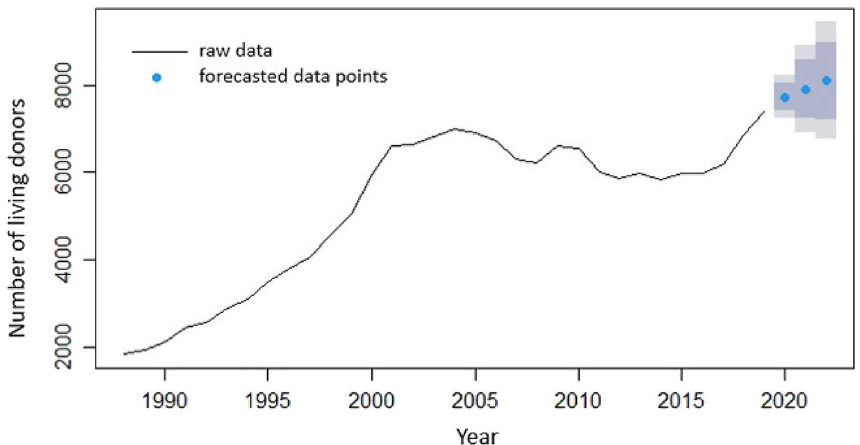
Figure 10. Raw data (pointwise data points connected by a line to show the change in the number of donors) for living organ donors and forecasted data (blue dots) depicting predictions by the ARIMA model for years 2020 through 2022. Also shown are the 80% confidence interval (dark grey) and the 95% confidence interval (light grey).